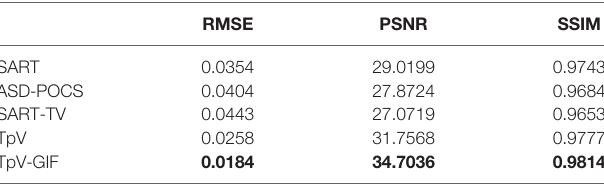
Bold values are the results of our method, RMSE, PSNR,SSIM have been shown in equation